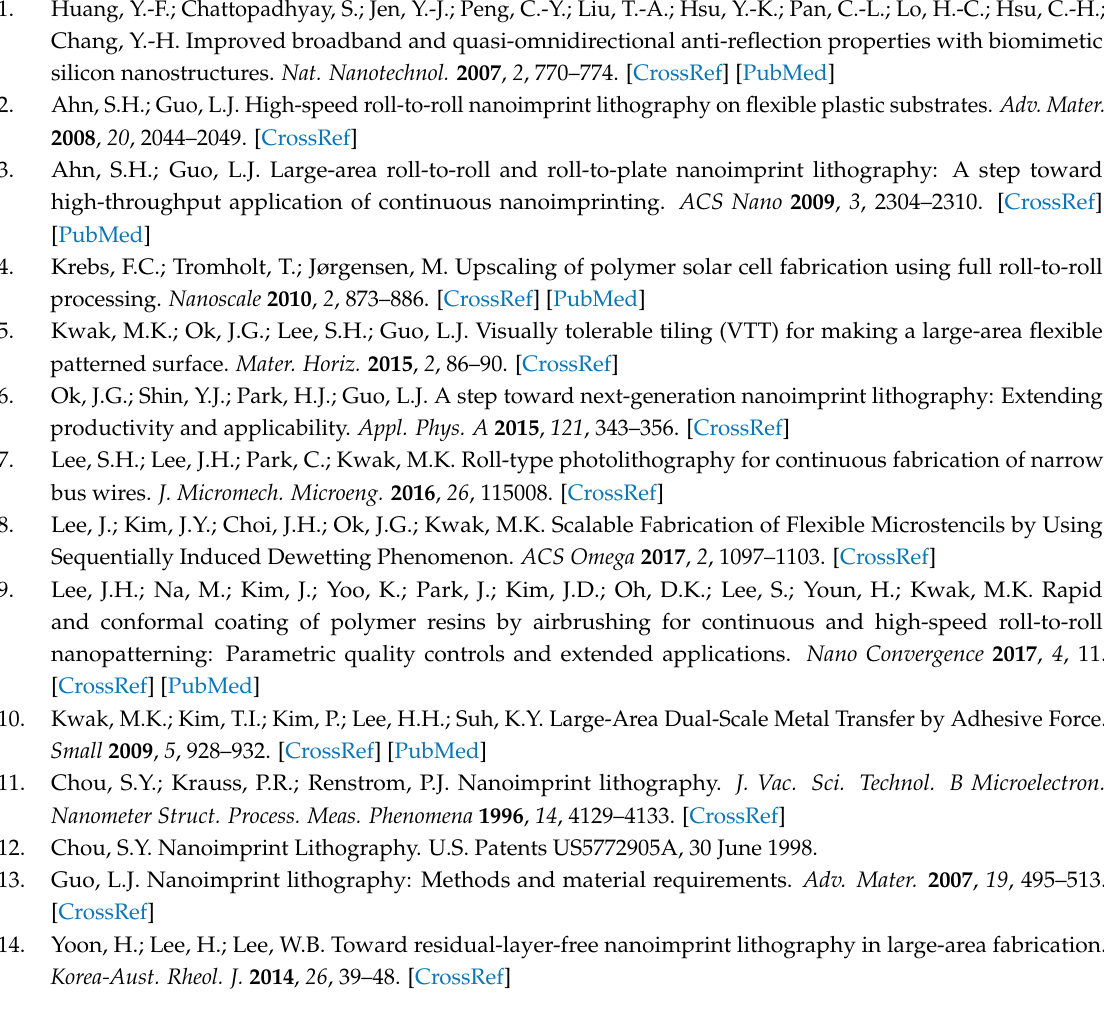
s1. Figure S1: Experimental procedure using tape to define the tile shapes; Figure S2: (a) A PDMS mold, with tape to remove the outside of the boundary. (b) The prepolymer, clearly removed by detaching the tape. (c) The PUA mold, adhered using tape. (d) The sticky residues remaining on the PUA